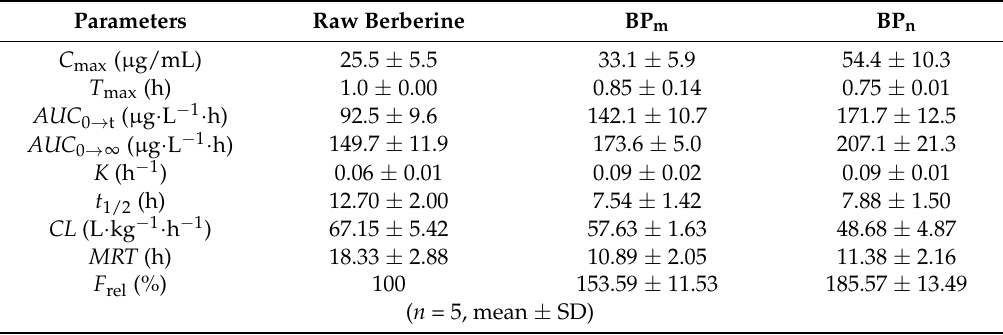
Table 3. Pharmacokinetic parameters of berberine for raw berberine, BP m , and BP n in rat